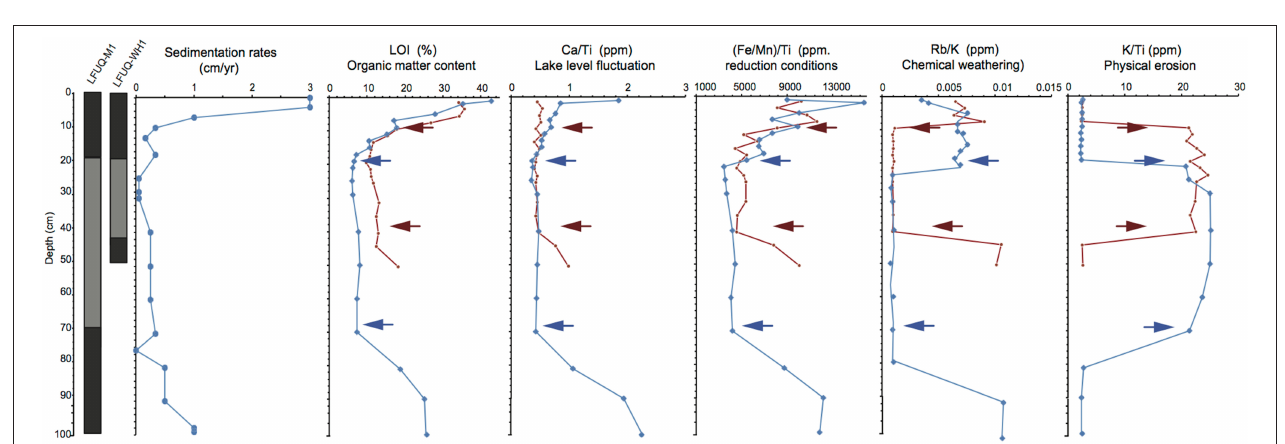
FIGURE 3 | Chronology of the dated depth profiles of core LFUQ-M1. Dates and ages and standard deviations are presented according to our combined age model using 210 Pb radiometric analysis and 14 C AMS analysis on plant macrofossil material (seeds and leaves). The 14 C AMS publication codes are presented for each of the analyzed samples (31–32cm; 75–67cm; 98–99cm).